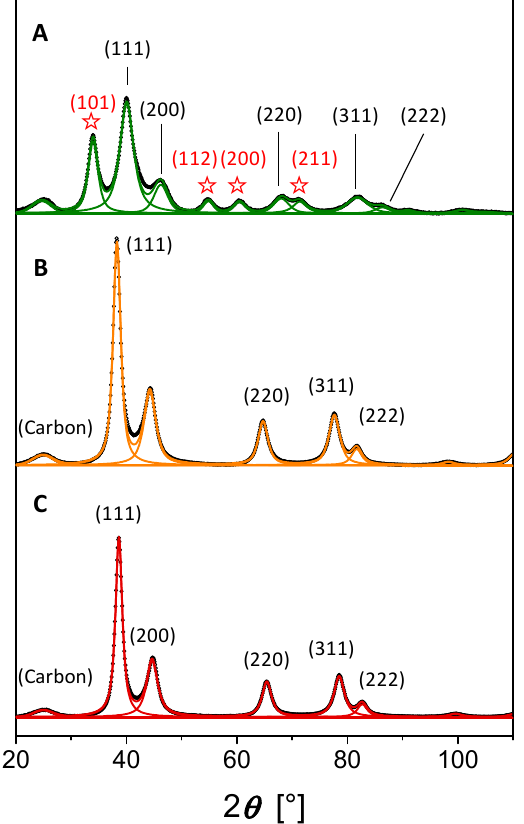
Figure 2. XRD patterns of ( A ) Pd/C ( ☆ indicates the diffraction peaks related to the tetragonal PdO structure from the JCPDS card n°41-1107), ( B ) Au/C and ( C ) Pd 3 Au 7 /C materials prepared from the “water in oil” microemulsion from the JCPDS cards No. 05-0681 (face centered cubic Pd) and n°04- 0784 (face centered cubic Au).